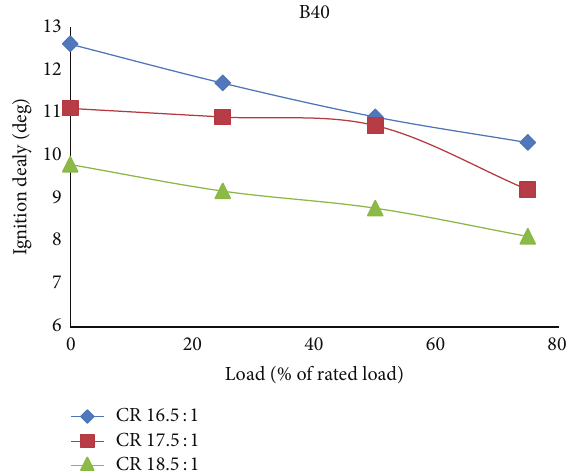
Figure 8: Effect of different compression ratios for B40 fuel at different